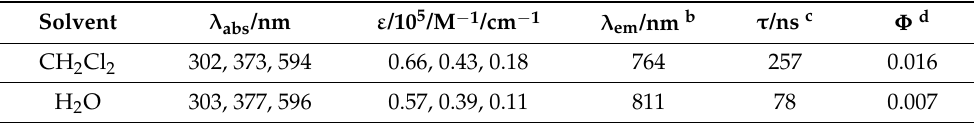
Table 1. Photophysical data of Ir(III) complex a .